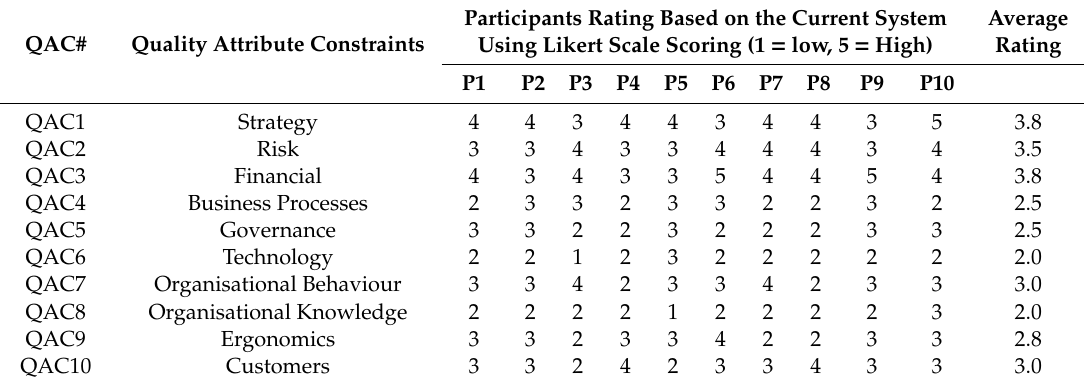
Table 3. Current regulatory policy system evaluation.